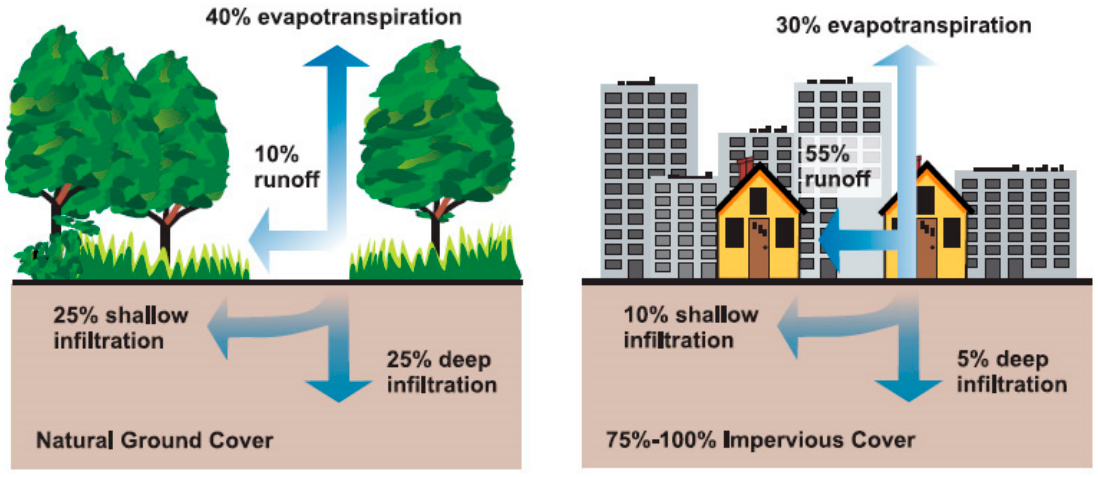
Figure 5. Water cycle comparison of urban and natural landscapes. Reproduced from US Environmental Protection Agency Doc. No: EPA 841 ‐ F ‐ 03 ‐ 003 [99].